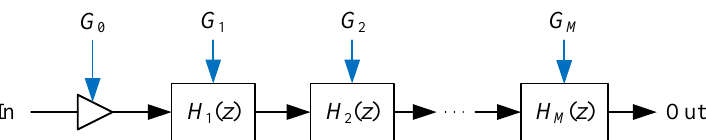
Figure 7. Cascade implementation of a graphic equalizer. Equalizing filters H m ( z ) are controlled with command gain parameters G m , as indicated with blue